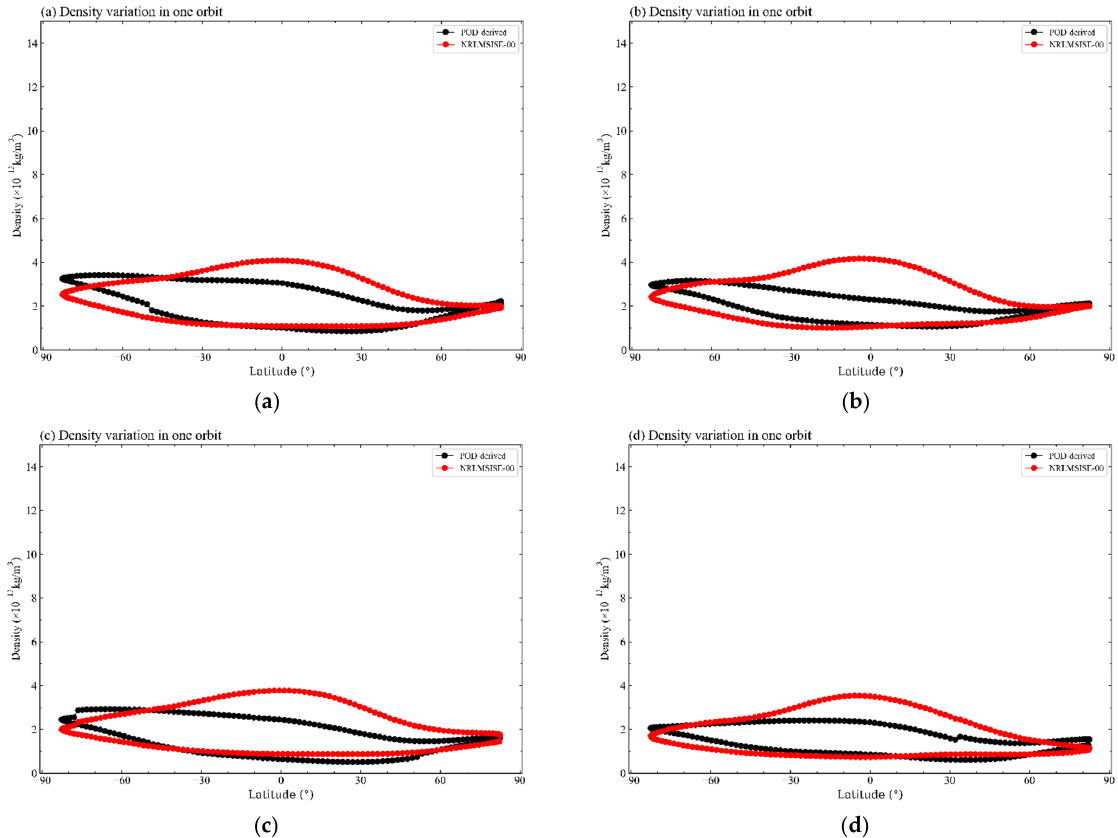
Figure 6. The density variations during one orbital period, especially in the quiet period. ( a , b ) De- scription of the density variations on 1 November 2021. ( c , d ) Description of the density